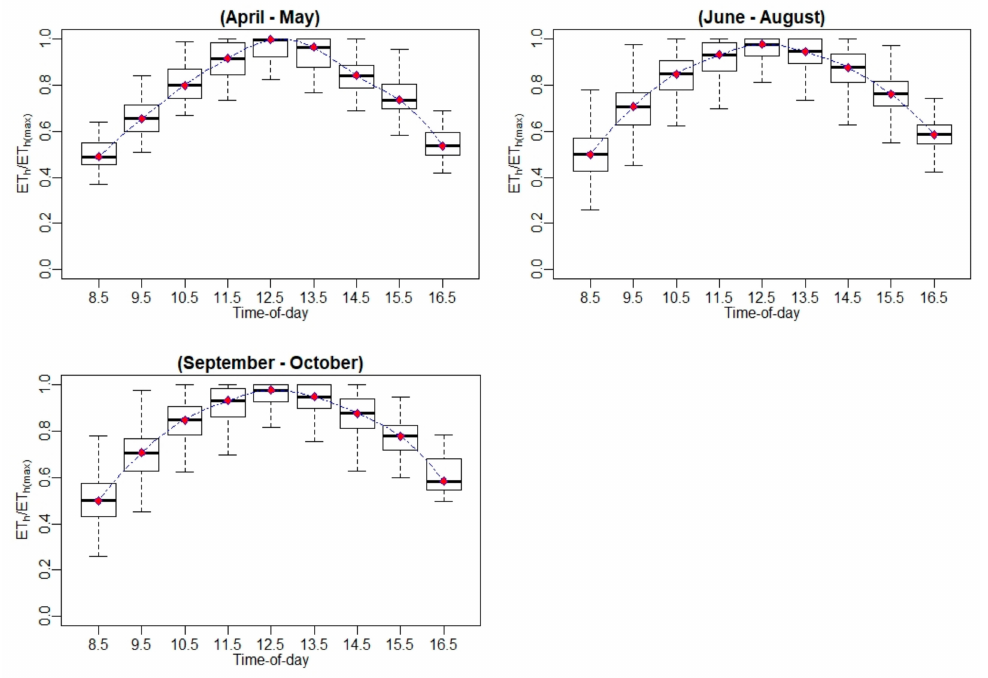
Figure A13. Hourly ET -to-maximum hourly ET ratio ( ET h /ET h(max) ) variation using EC measurements.